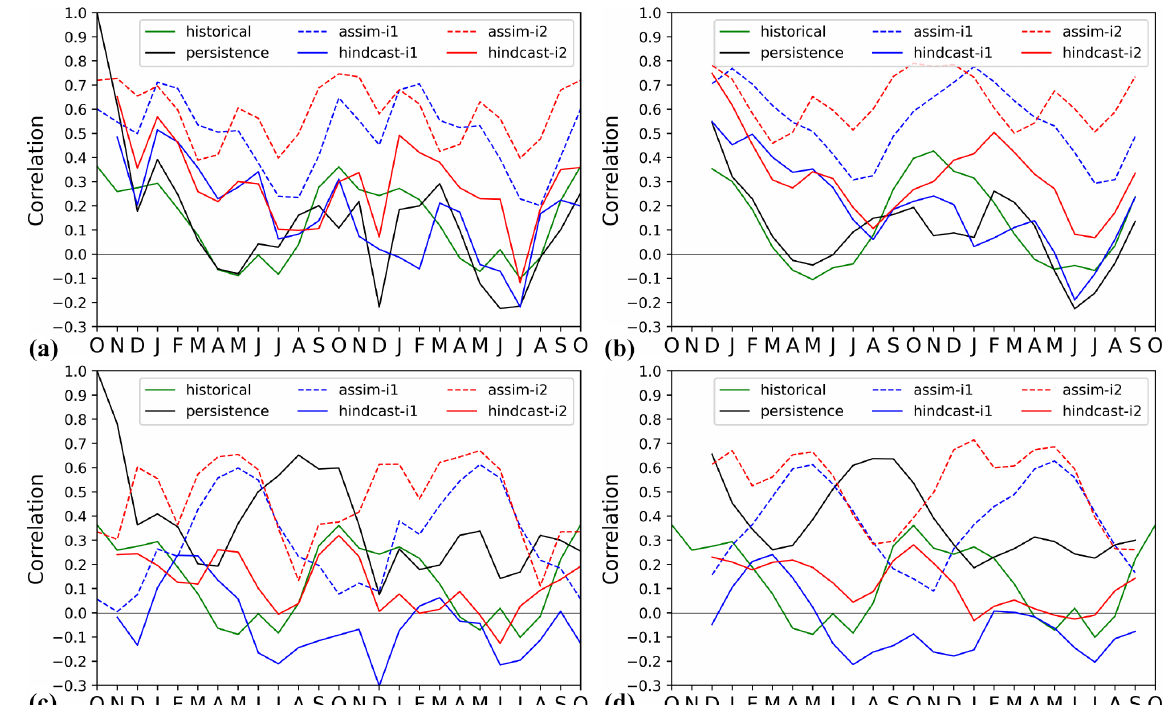
Figure 17. ACC for Arctic (a, b) and Antarctic (c, d) total ice area as a function of lead month for monthly averages (a, c) and 3-month averages (b, d) . The persistence forecast uses the observed October mean, while the hindcasts were initialized 1 November. Observations are from HadISST1 (Rayner et al., 2003) and limited to the satellite era